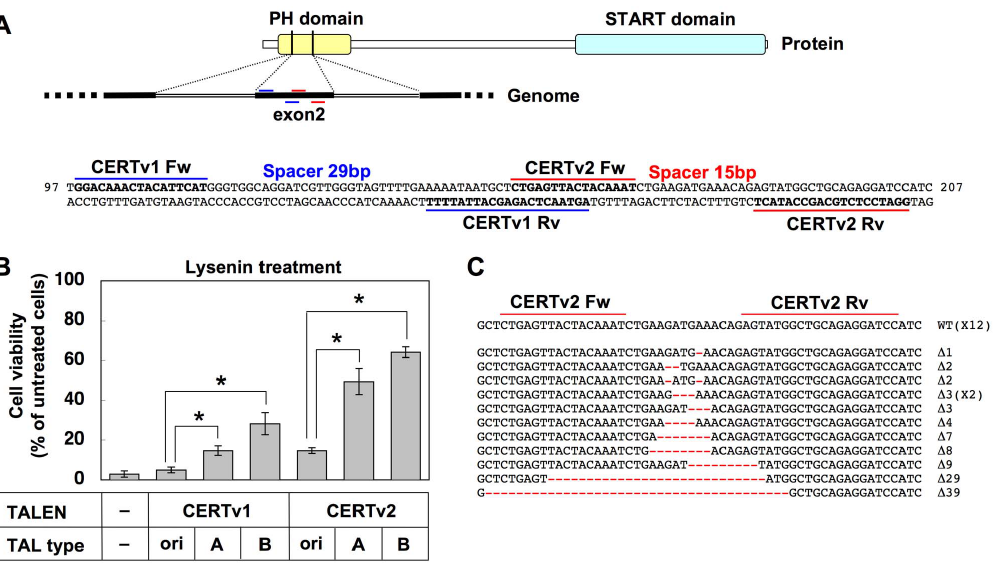
Figure 3. Evaluation of CERT gene disruption by TALEN-CERT pairs in HeLa cells. A, Target sites of TALENs-CERT pairs (version 1 and 2) in human CERT gene. The sequences are located in exon 2, which codes part of the PH domain. The target sites are shown in bold. The numbers on the right and left of the sequence indicate the sequence numbers from the A of the translation initiation codon, based on CERT mRNA (accession number AY4533859). B, Resistance to lysenin in TALEN-CERT–treated HeLa cells. Six TALEN-CERT pairs, which contain two pairs of repeat modules directed against different target sites (CERTv1 and v2) contained in three TALEN scaffolds (TAL original (ori), TAL-ModA, and TAL-ModB), as well as the empty vector (–). These TALEN pairs were transfected into HeLa-mCAT # 8 cells, followed by 30 u C incubation. The cells were treated with lysenin at 800 ng/ ml for 2 h. Their viability was estimated by the MTT assay and is expressing as a percentage of the value (OD570) in the absence of lysenin: mean percentage 6 S.D. obtained from three independently repeated experiments. The Bonferroni corrected t -test was used for multiple comparisons. *, p , 0.017. C, Indel analysis of TALEN-CERT–treated HeLa cells. The pair of target sites is shown in bold. Indels are shown in red and their lengths are specified on the right of the